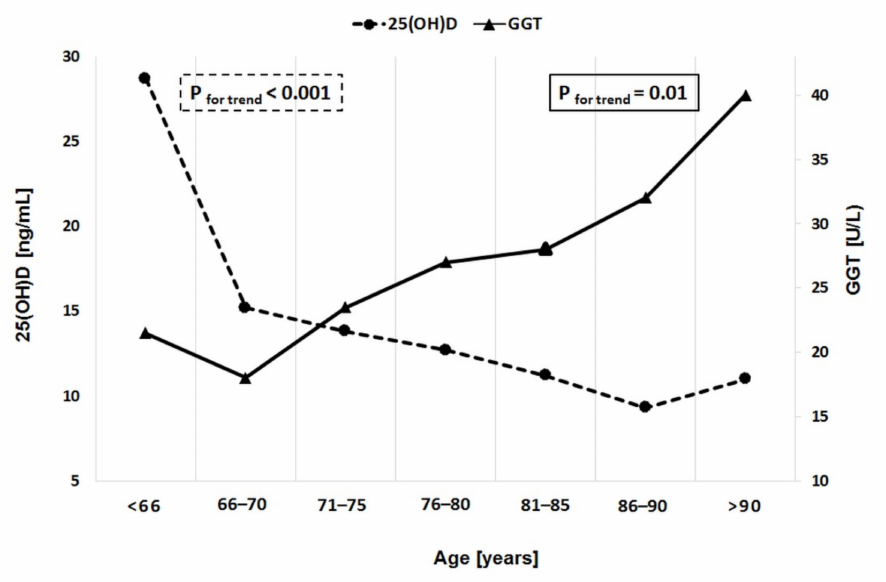
Figure 1. Age range-dependent changes in 25-hydroxyvitamin D (25(OHD)) and gamma glutamyltransfarase (GGT) levels.